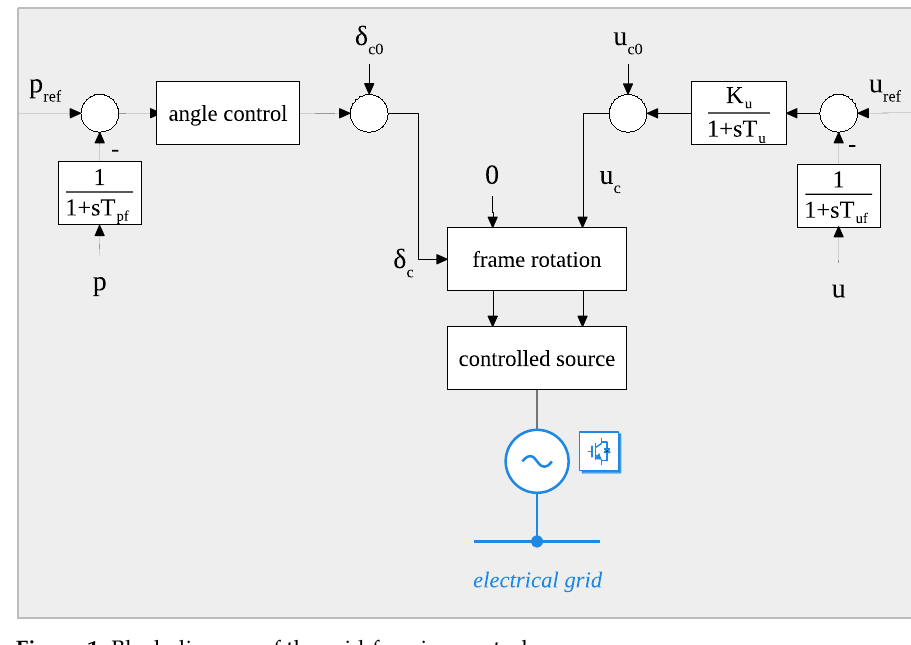
Figure 1. Block diagram of the grid-forming control.